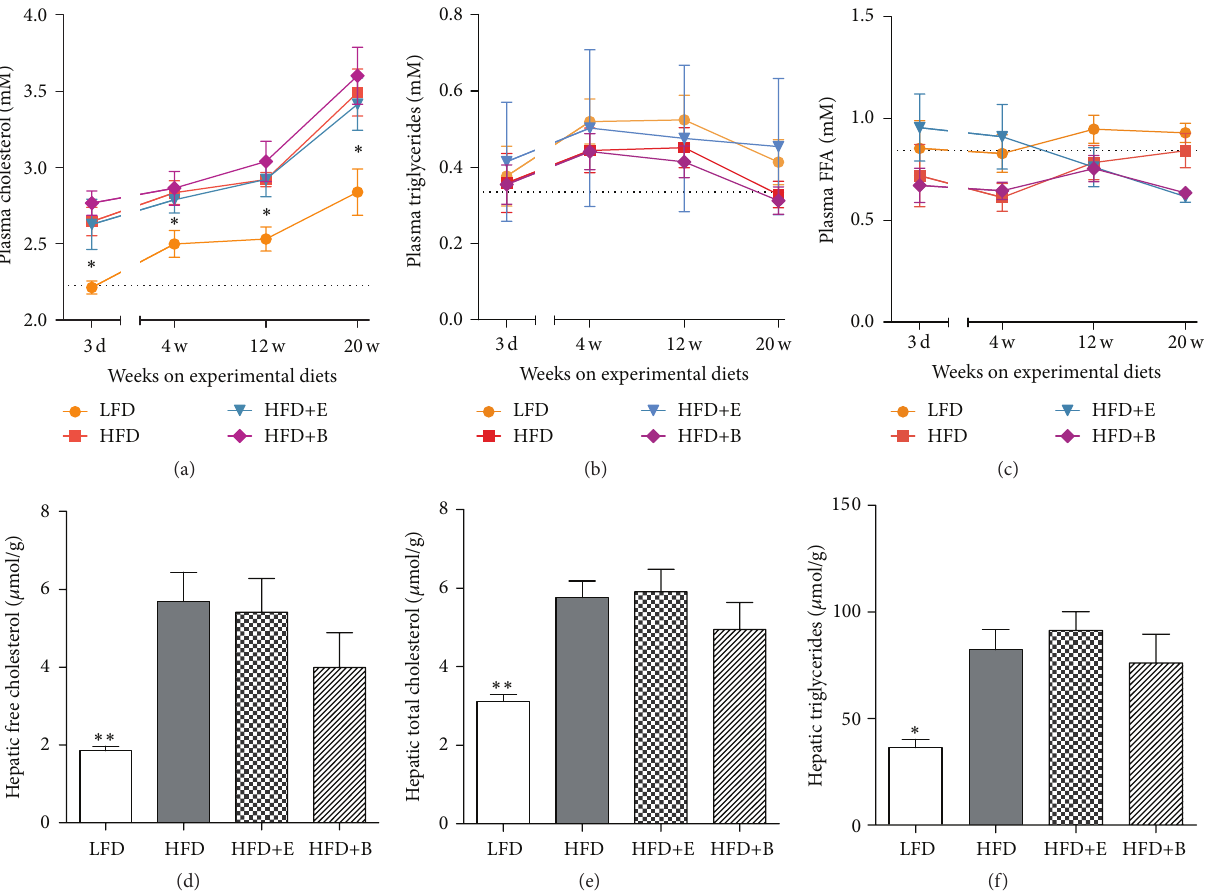
Figure 3: Systemic and hepatic lipids. Serial plasma (a) cholesterol ( 2.23 ± 0.04 at baseline), (b) triglycerides ( 0.34 ± 0.04 at baseline), and (c) free fatty acids ( 0.84 ± 0.06 at baseline), as well as hepatic (d) free cholesterol, (e) total cholesterol, and (f) triglyceride content, are not affected by polyphenol supplementation. Dotted lines depict baseline values. Significant from HFD ( ∗ 𝑝 < 0.05, ∗∗ 𝑝 < 0.01